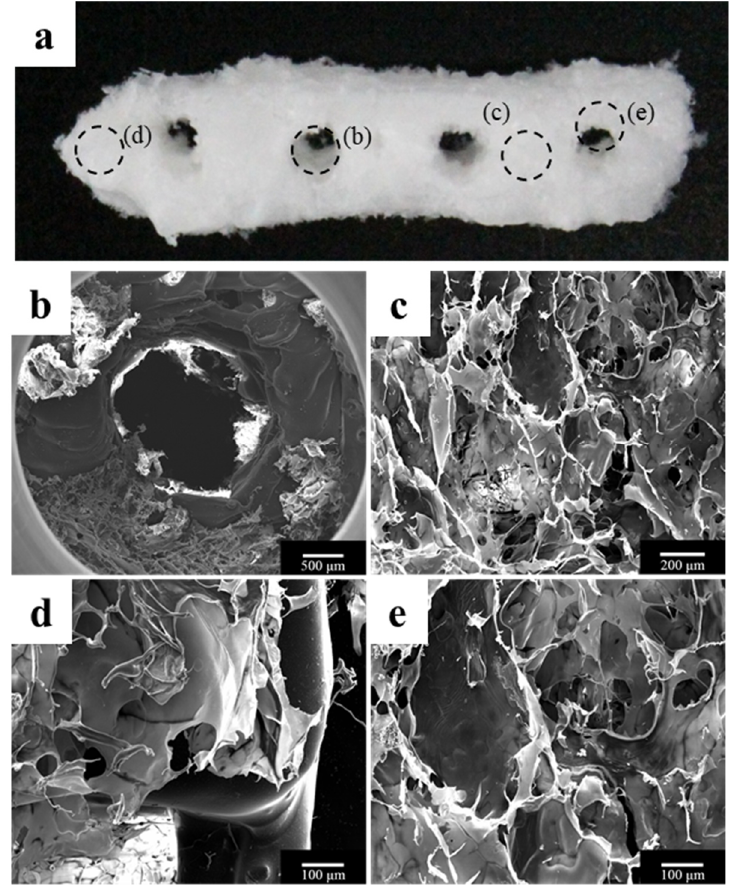
Figure 1. Morphology of the polycaprolactone (PCL)/ β -tricalcium phosphate ( β -TCP)/bone decellularized extracellular matrix (bdECM) scaffold. ( a ) Visual image of the scaffold; ( b ) An implant through hole, which plays a role in guiding the implant fixture and ( c – e ) Bone decellularized extracellular matrix (bdECM) coated on the scaffold.